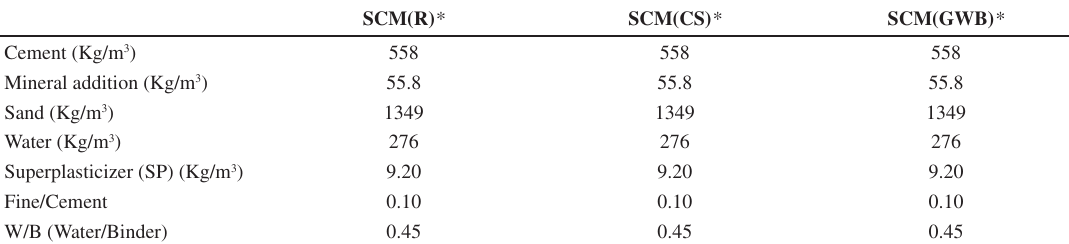
Table 2. Details of